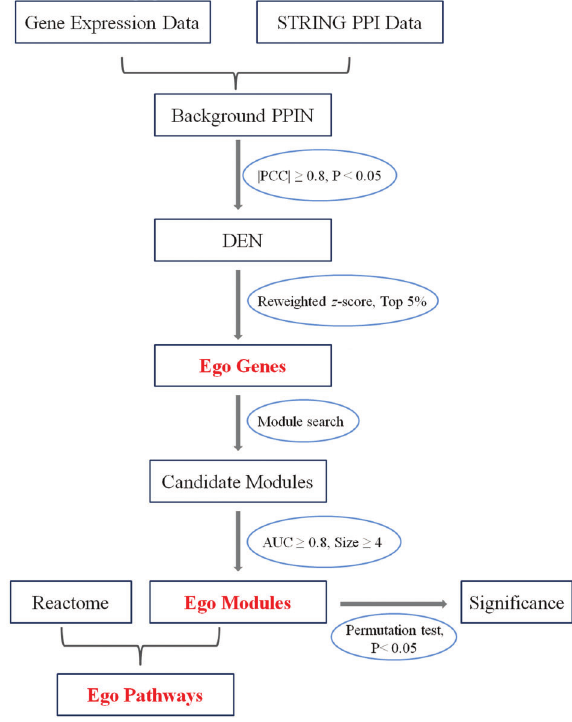
Figure 1. Flow chart for identi fi cation of ego genes, modules and pathways in osteosarcoma. PPI: protein-protein interaction; PPIN: PPI network; DEN: differential expression network; AUC; area under the receiver operating characteristic (ROC)